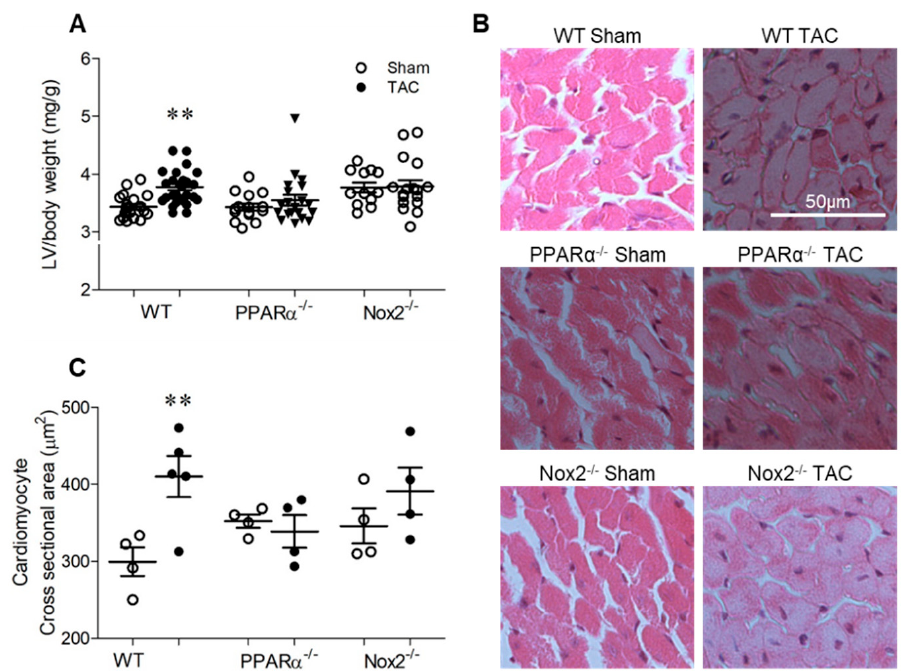
Figure 2. Pressure overload-induced cardiac hypertrophy is dependent upon PPAR α and Nox2. ( A ) Hypertrophic increases in LV weight normalised to body weight following pressure overload in WT animals are not evident with PPAR α − / − or Nox2 − / − ( N = 12–28). ( B ) Representative images of LV sections stained with haematoxylin and eosin with ( C ) quantification of mean cardiomyocyte cross-sectional area ( N = 4–5). Mean ± SEM; ** p < 0.01 vs. corresponding sham.